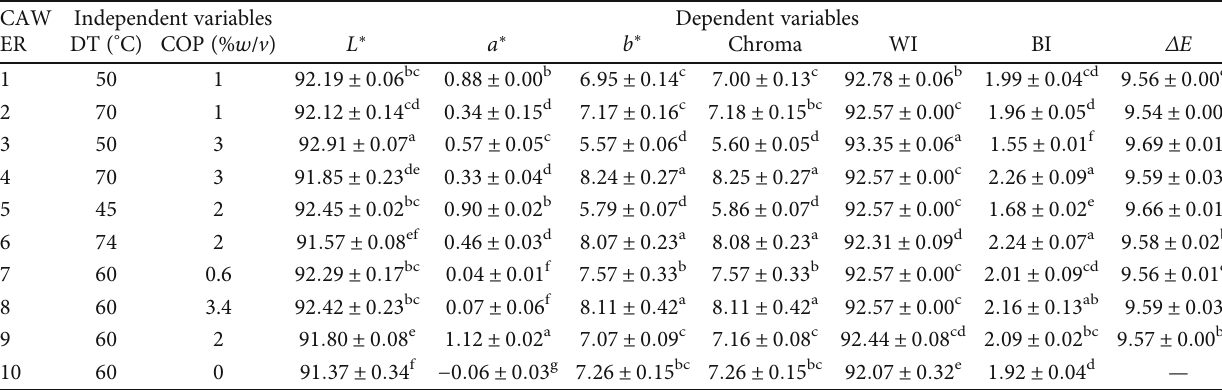
Table 8: Experimental runs and colour properties of cassava fl our (CAW) under di ff erent processing conditions. CAW Independent variables Dependent